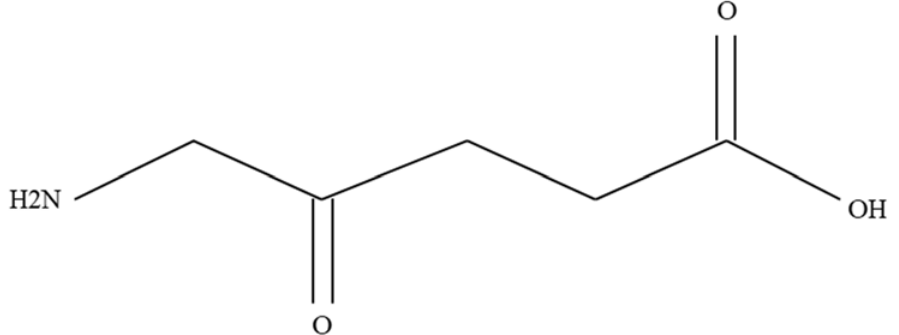
Figure 4. 5-aminolevulinic acid molecule [104]. Figure 4. 5 ‐ aminolevulinic acid molecule [104].